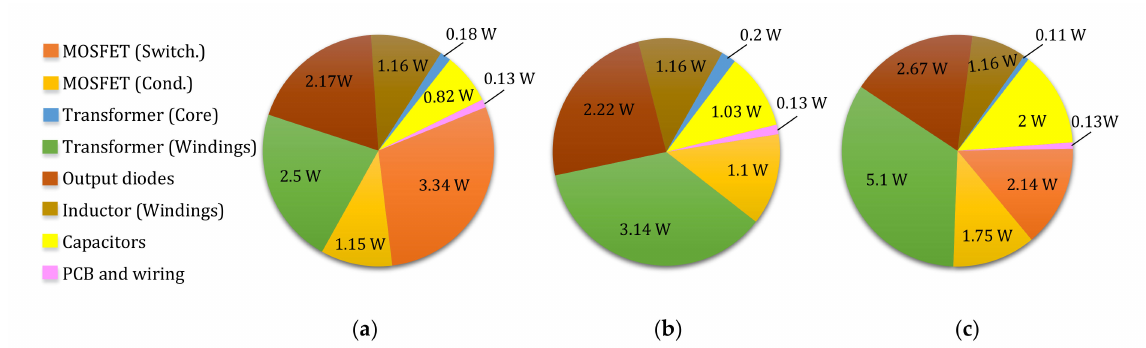
Figure 6. Distribution of power losses at the input power of 300 W for the turns ratio of: ( a ) n 1 = 5.7, ( b ) n = 6.1, and ( c ) n 2 =